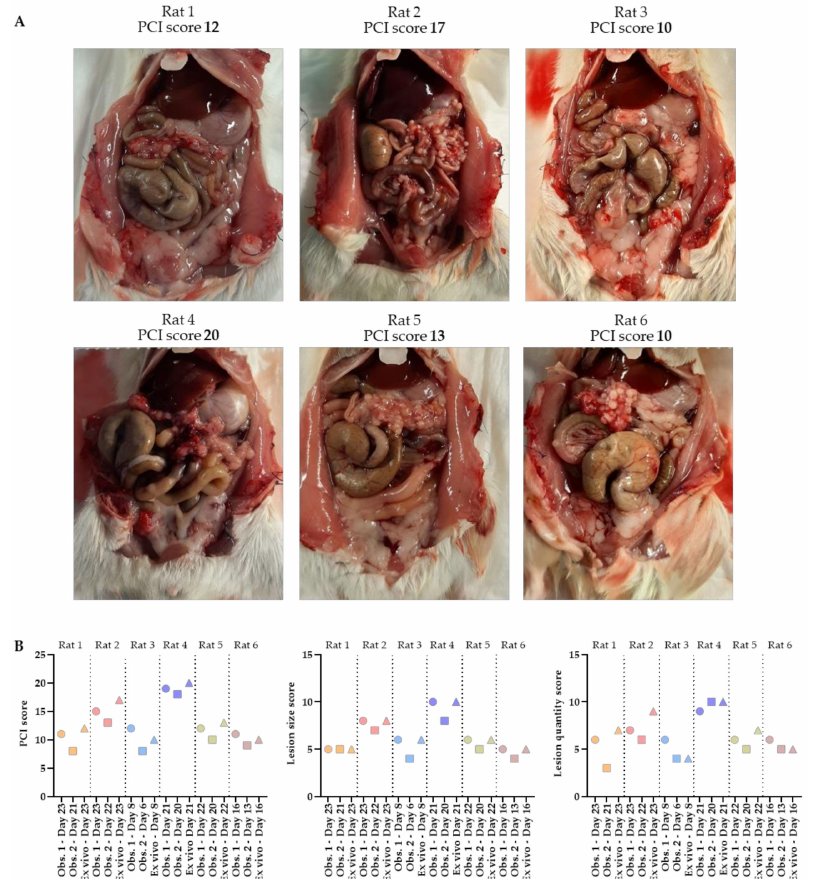
Figure 5. Abdomens of the six rats with corresponding ex vivo PCI scores ( A ). The total PCI, lesion size and lesion quantity scores predicted on ultrasound by 2 independent observers, as well as the ex vivo scoring, are shown in these graphs ( B ). PCI scoring was performed by one of the two observers when tumors reached the size of 4–6 mm, followed by the second ultrasound scoring within 3 days after the animal was sacrificed in order to score the PCI ex